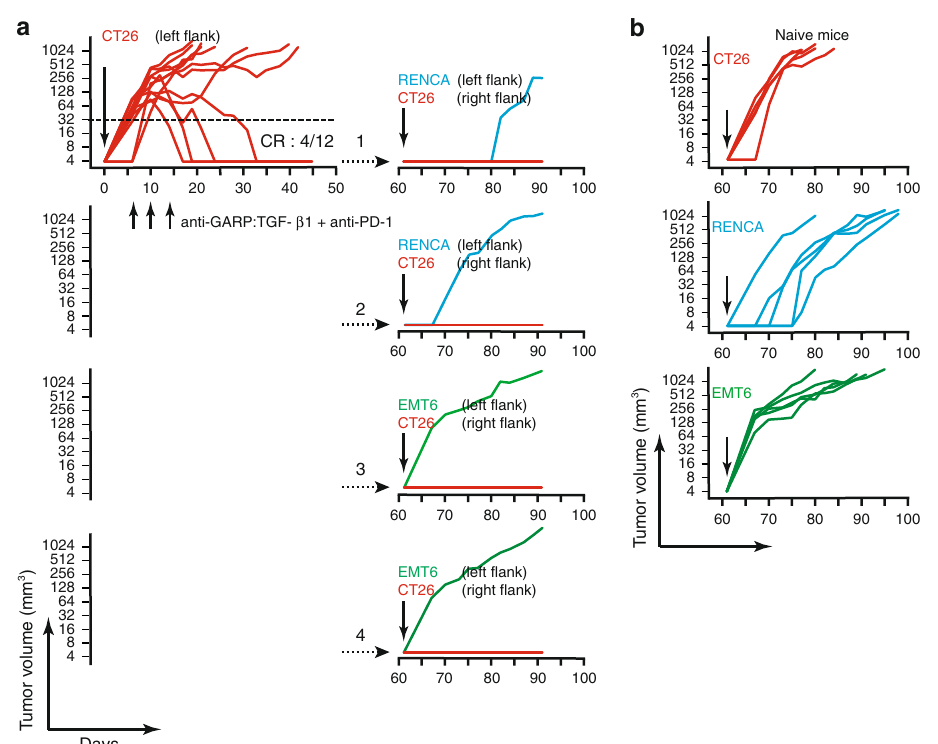
Fig. 4 Combined blockade of GARP:TGF- β 1 and PD-1 induces protective, CT26-speci fi c immunity. a On day 0, live CT26 cells were injected in the left fl ank of BALB/c mice ( n = 12; 10 6 cells/mouse). Anti-GARP:TGF- β 1 WT combined with anti-PD-1 WT were injected i.p. on days 6, 10, and 14. Graph on the left shows evolution of tumor volumes until day 50 in individual mice, and the ratio (CR) indicates the proportion of mice that completely rejected their tumor. On day 61, the four mice that had rejected their tumor were re-injected in the right fl ank with live CT26 cells (10 6 cells/mouse, red lines), and in the left fl ank with syngeneic RENCA (10 6 cells/mouse, blue lines) or EMT6 cells (3 × 10 5 cells/mouse, green lines). Each graph on the right shows evolution of tumor volumes in the left and right fl anks in one of the four re-challenged mice. In all cases, mice were euthanized when the surface of any tumor was ≥ 200 mm 2 . b On day 61, control naive BALB/c mice ( n = 5 per group) were injected in the left fl ank with live CT26, RENCA or EMT6 tumor cells (cell numbers as in a ). Graphs show evolution of tumor volumes in individual